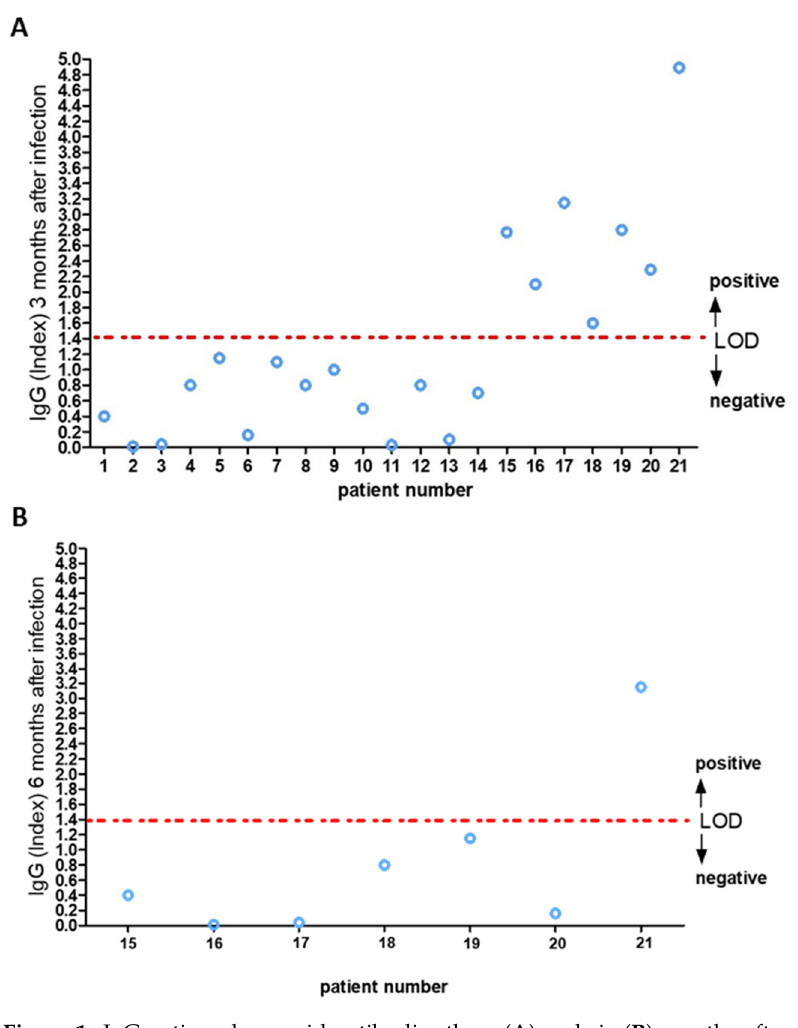
Figure 1. IgG anti-nucleocapsid antibodies three ( A ) and six ( B ) months after infection. Limit of detection (LOD) index equal to 1.4.